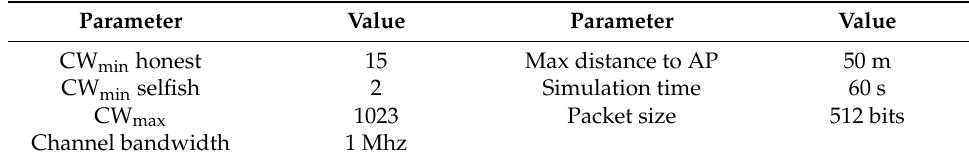
Table 1. Simulation parameters. Parameter Value Parameter Value CW min honest